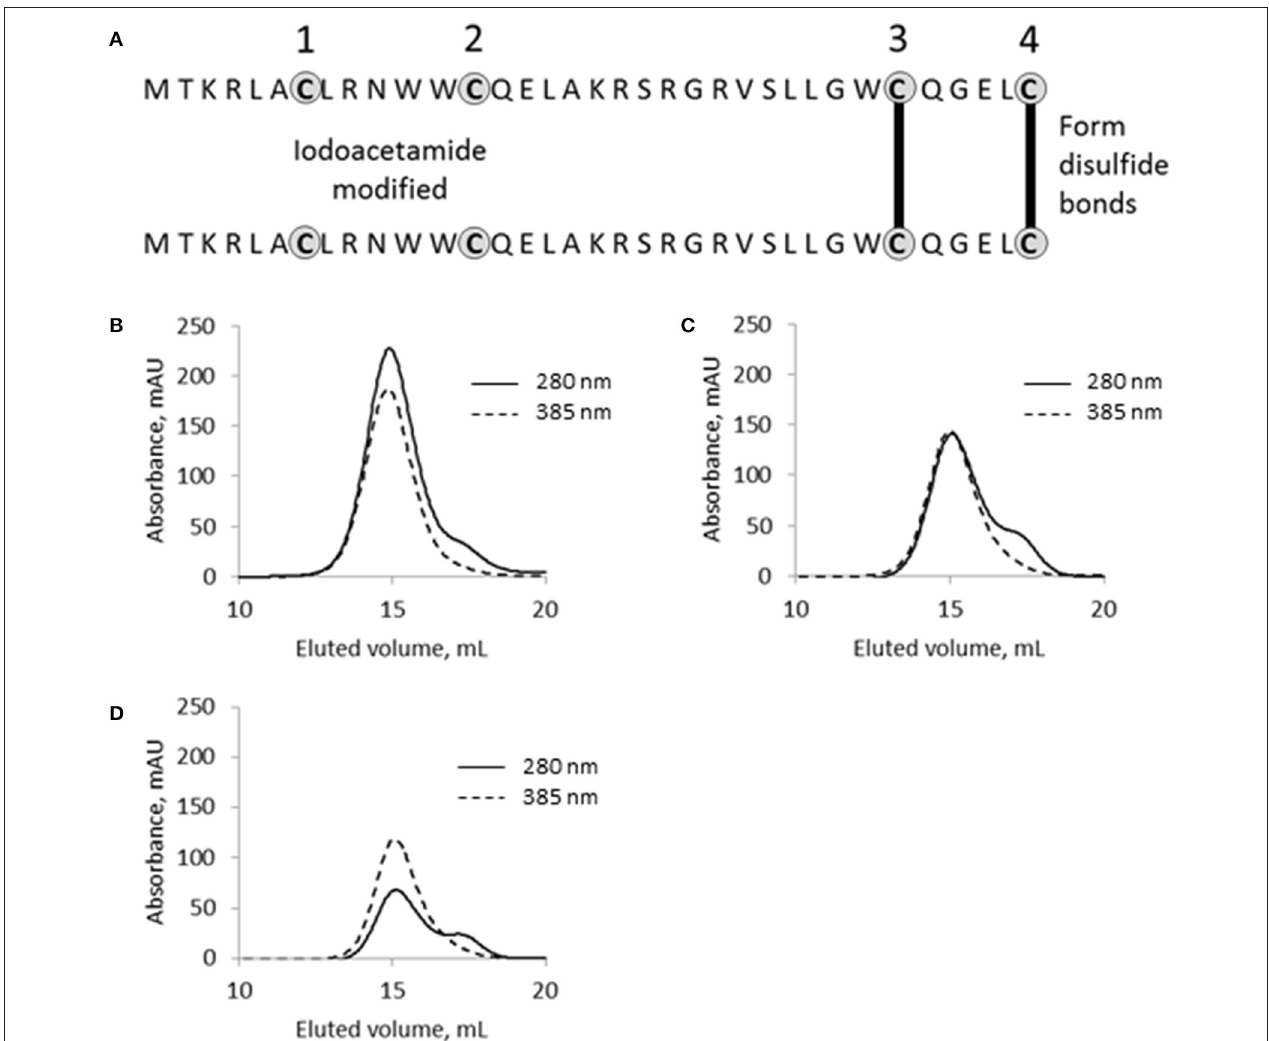
FIGURE 7 | The functional role of cysteine residues in SpyB. (A) Schematic of SpyB modification by iodoacetamide. The size-exclusion chromatogram of (B) MBP-SpyB WT, (C) double (C7A/C13A), and (D) quadruple (C7A/C13A/C30A/C35A) mutants reconstituted with hemin. The absorbance was monitored at 280 and 385 nm (hemin). Data are representative of biological